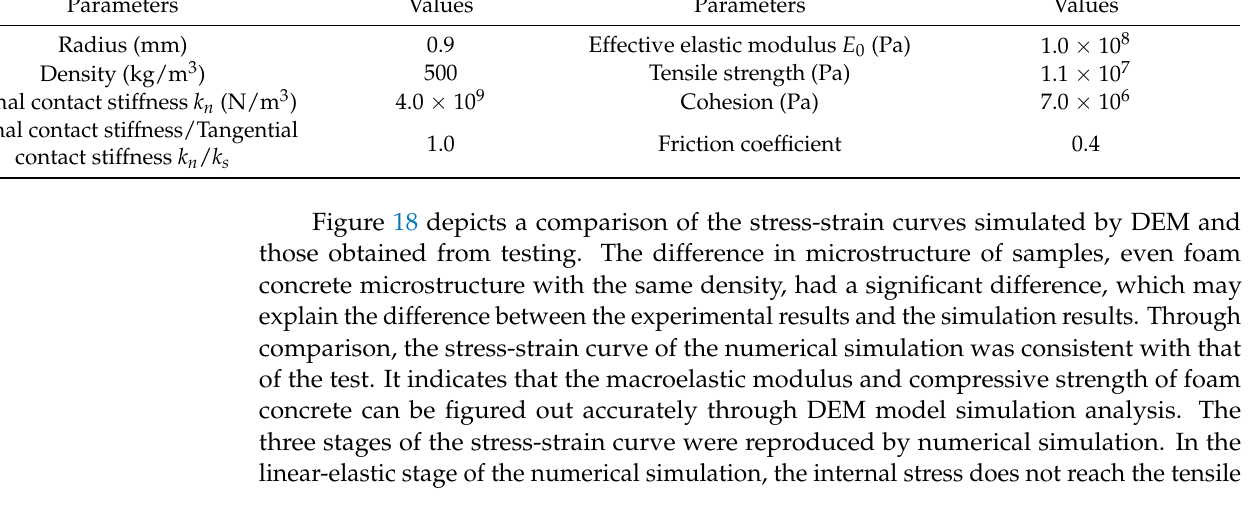
Figure 17. Stress-strain curves of the foamed concrete models with five kinds of cement paste sizes.